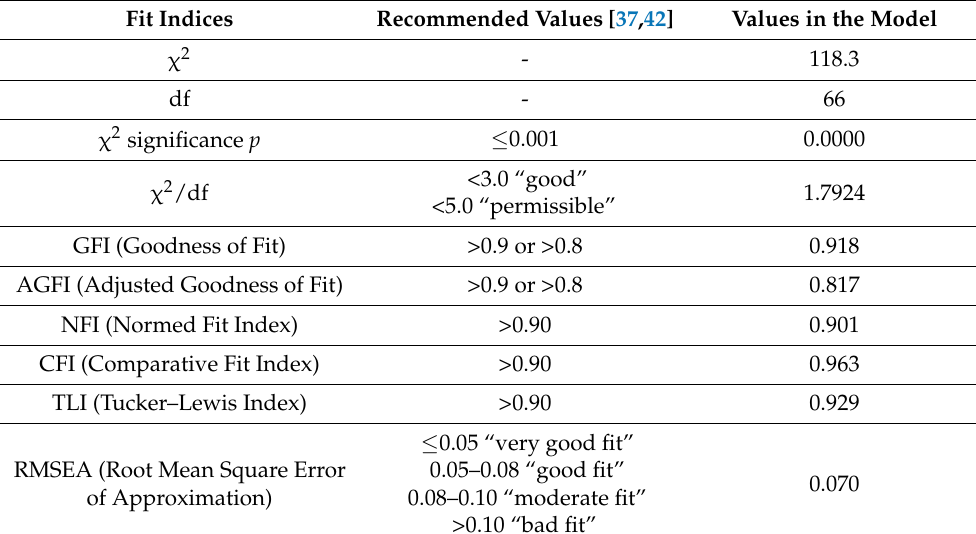
Table 3. Fit indices for confirmatory factor analysis model for heavy mobile machinery operators— checklist